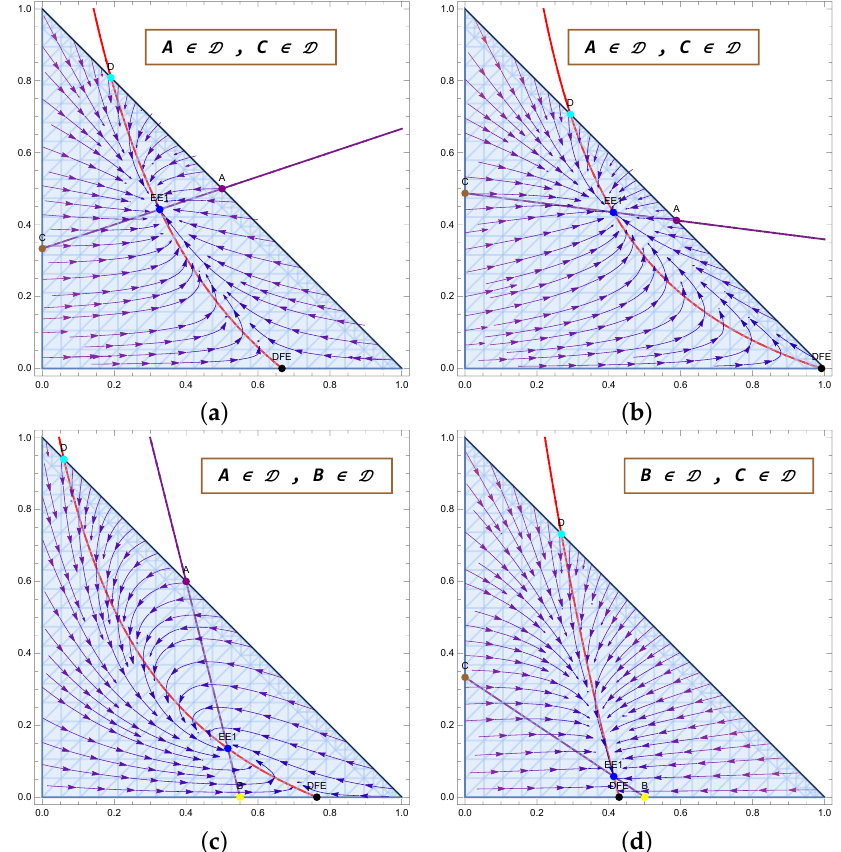
Figure 3. Stream plots of ( s , i ) when γ s > 0, in four cases when R 0 > 1. The DFE is a saddle point